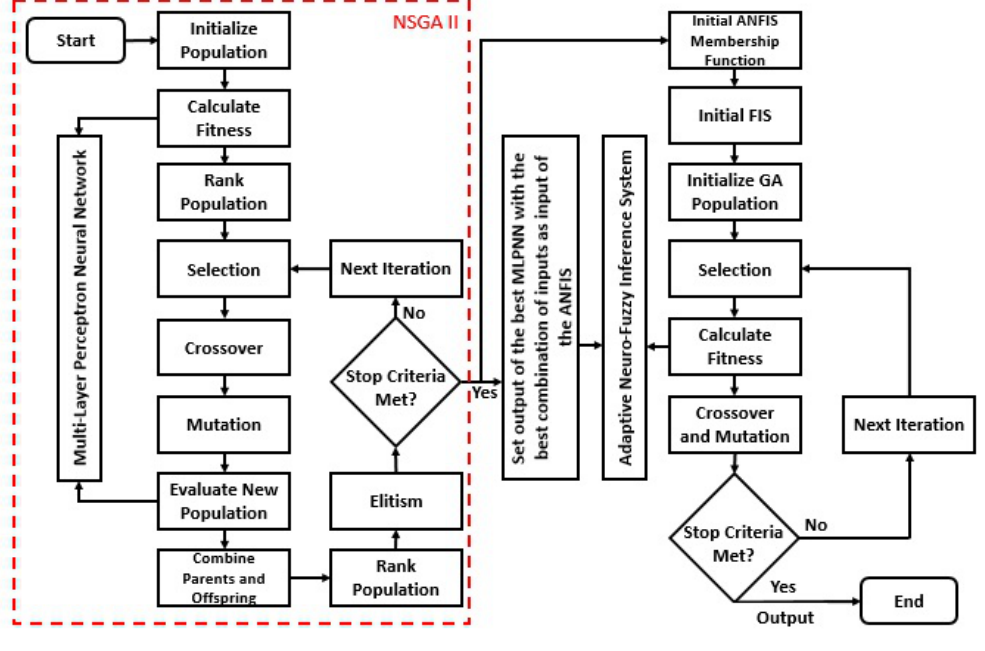
Figure 3. Proposed